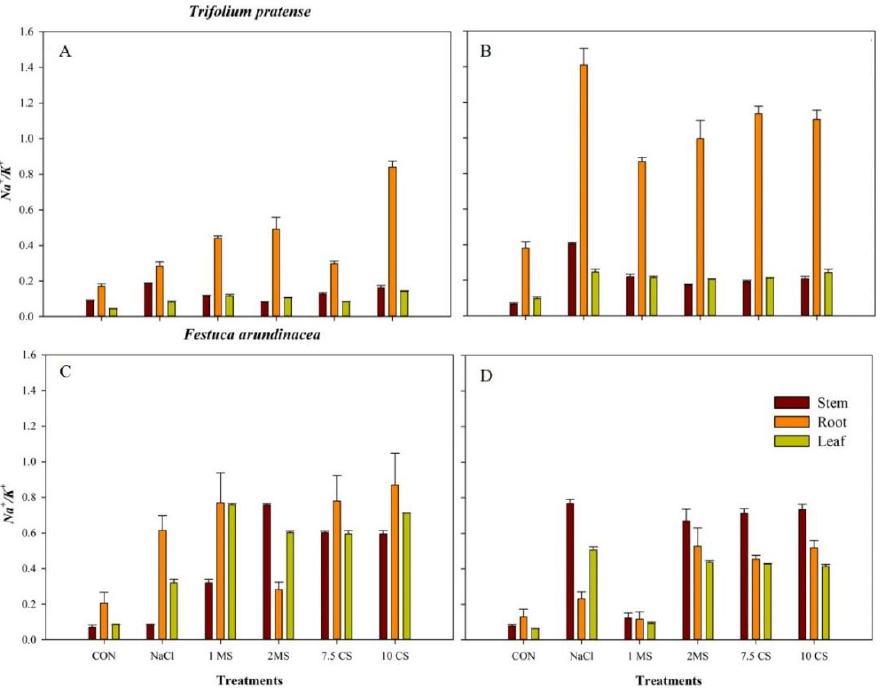
Figure 5. Na + /K + ratio of T. pratense 60 DAT ( A ), 120 DAT ( B ) and F. arundinacea 60 DAT ( C ), 120 DAT ( D ) stem, root, and leaves of under different treatments.